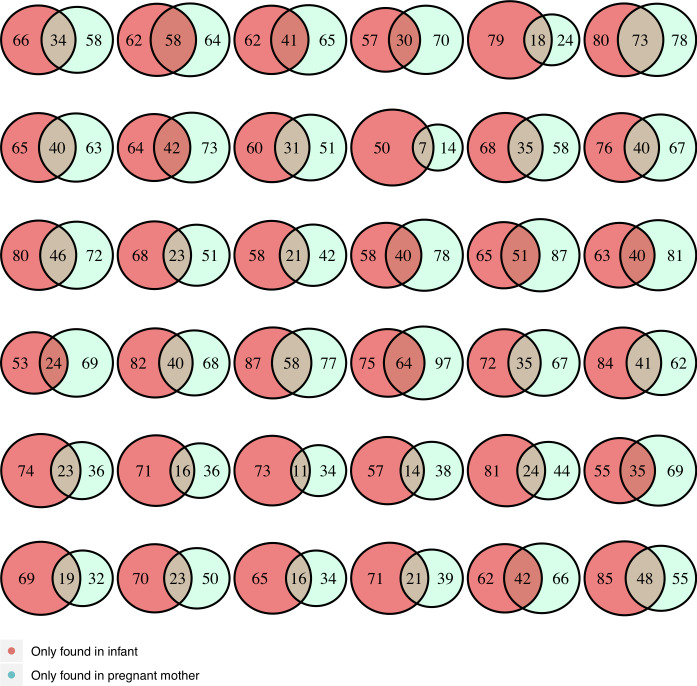
Number of ARG/MGE shared within dyads.